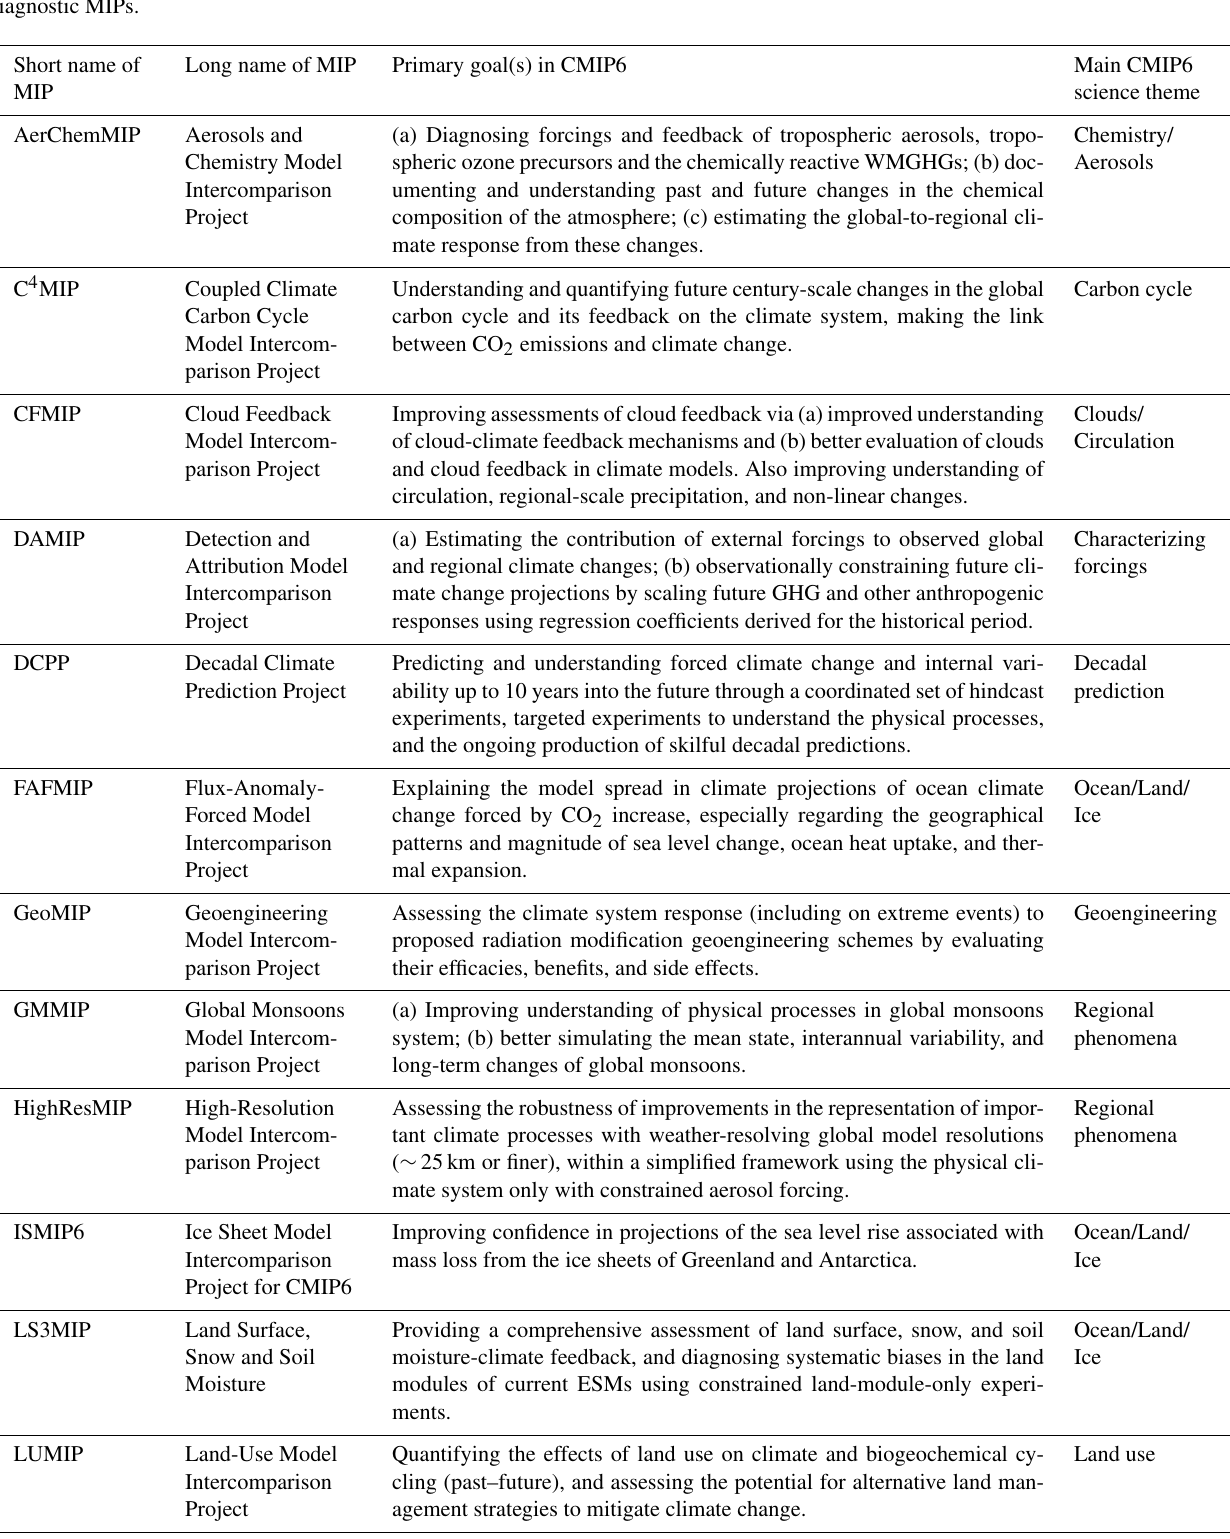
Table 3. List of CMIP6-Endorsed MIPs along with the long name of the MIP, the primary goal(s) and the main CMIP6 science theme as displayed in Fig. 2. Each of these MIPs is described in more detail in a separate contribution to this special issue. MIPs marked with ∗ are diagnostic